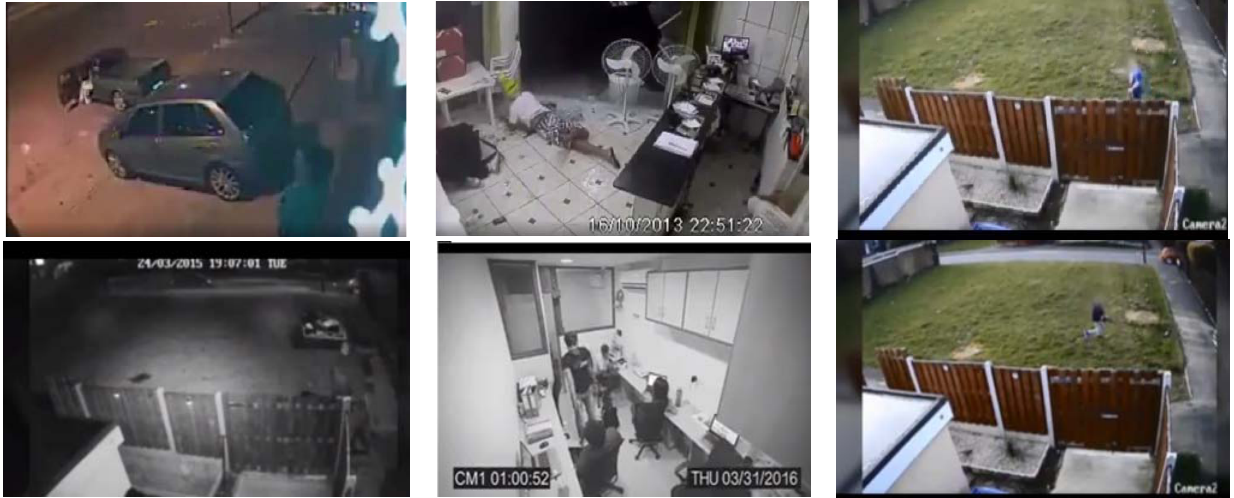
Figure 5. Identification of shooting action from the dataset with different places and different ob ‐ jects.